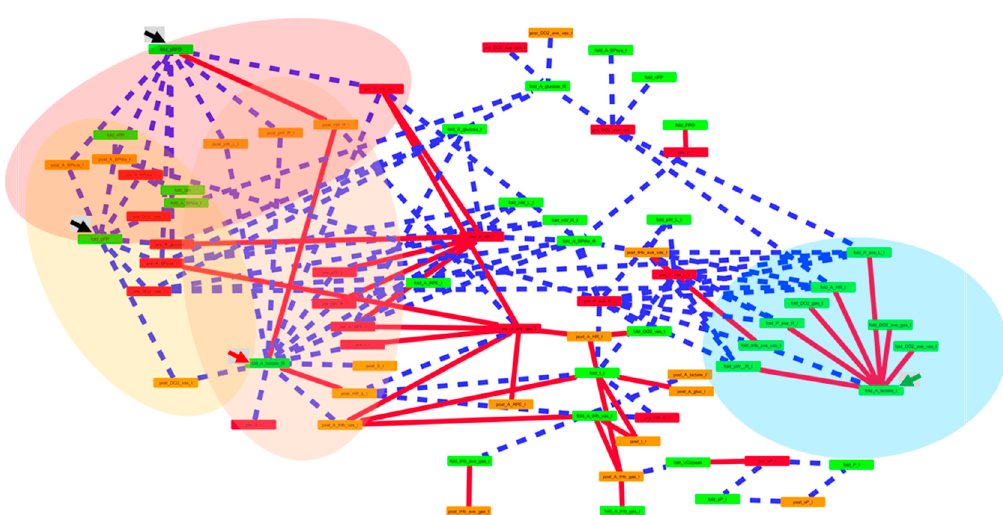
Figure 5. Connectivity of correlations between stress during the stimulus of interval exercise and the adjustments with training. Network display of the 131 linear relationships between indices of metabolic and mechanical stress during interval exercise and training-induced adjustments (nodes) for Pearson correlations, which passed a threshold of |r| > 0.70 and p < 0.05. Straight red and stippled blue lines, respectively, indicate positive and negative correlations. The strength of the correlation is indicated by the thickness of the lines connecting two nodes. Red and orange colored nodes highlight stress during the first and last session of interval exercise, respectively. Green colored nodes emphasize training-induced fold changes. Note the high connectivity with parameters demonstrating an interaction effect of interval training × the contraction group with the reddish-indicated indices of stress during interval exercise that define (highlighted) entities. This comprises selective correlations of the green-highlighted fold changes in positive peak power and the corresponding rate of force development (black arrows), the fold changes for the AUC of the blood lactate concentration during the ramp test (red arrow) or during interval exercise (green arrow), with the AUC of the perceived exertion, heart rate, the systolic blood pressure, the hemoglobin accruing in m. gastrocnemius, and the oxygen deficit in m. vastus lateralis, and the average power during interval exercise. For the ramp exercise, only the AUCs over the same duration of exercise before training were considered. Abbreviation code: _A, AUC during exercise; BPdia, diastolic blood pressure; BPsys, systolic blood pressure; bm, body mass; DO2, oxygen deficit; DO2_ave, average oxygen deficit; fold, post vs. pre ratio; gas, m. gastrocnemius; glucose, blood glucose concentration; HR, heart rate; _I, during interval exercise; L, _S, number of intervals (sets); left leg; lactate, blood lactate concentration; nPP, negative peak power; nW, negative work; P_ave, average power; post, after training; PPO, peak power output during the ramp test; pPP, positive peak power; pre, prior to training; pW, positive work; rPP, reactive peak power; R, right leg; _R, during ramp test; pRFD, rate of force development during the development of positive peak power; RPE, rate of perceived exertion; sP, target power per PPO; _t, exercise duration; tHb, concentration of total hemoglobin; vas, m. vastus lateralis; tHb_ave, average concentration of total hemoglobin; VO2peak, peak oxygen